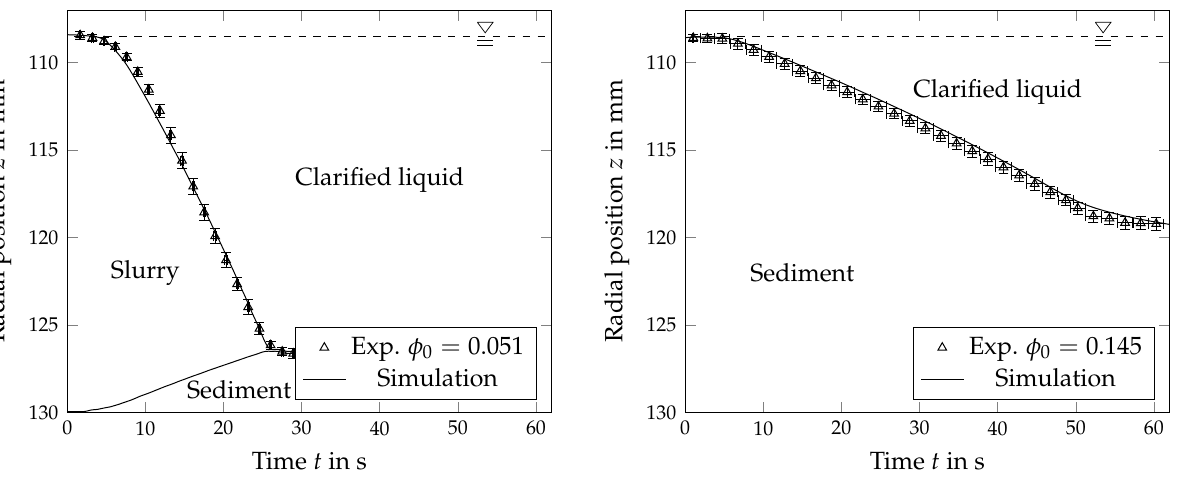
Figure 6. Comparison between experiment and simulation of the centrifugation process in a cuvette. The sedimentation of a slurry ( φ 0 = 0.051 < φ gel ) is shown on the left. The compression of a sediment ( φ 0 = 0.145 > φ gel ) is shown on the right.